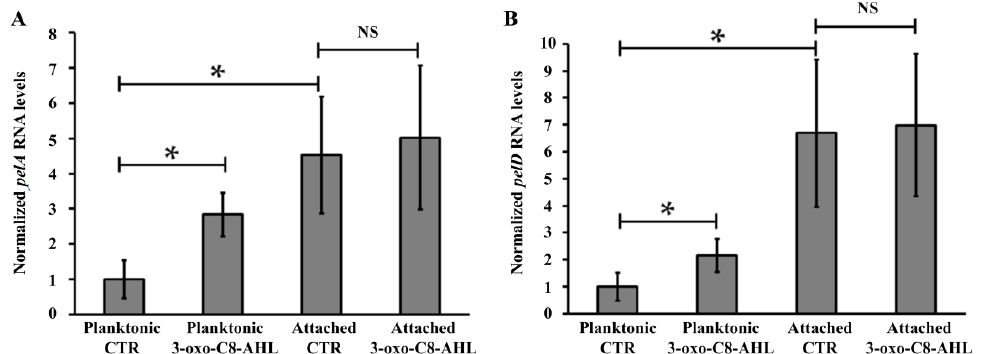
Figure 4. Effects of 3-oxo-C8-AHL addition on transcription levels of pelA and pelD genes. Transcript levels of pelA ( A ) and pelD ( B ) genes were measured by qRT-PCR. Total RNAs were obtained from 5-days growth cultures. Data were normalized using DNA 16S and map genes. Values represent the average of 4 independent experiments ± standard deviation. Significant differences calculated by a one-way ANOVA test ( p < 0.05) are noted (*). CTR, DMSO 0.01% without AHL. NS, No significant difference.